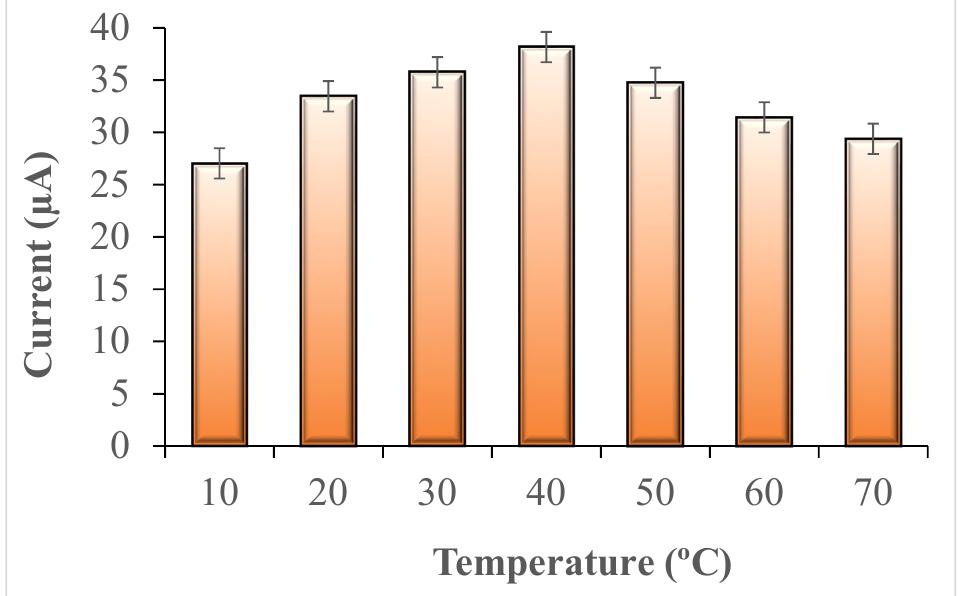
Figure 8. Determination of optimum temperature for the fabricated sensing platform.